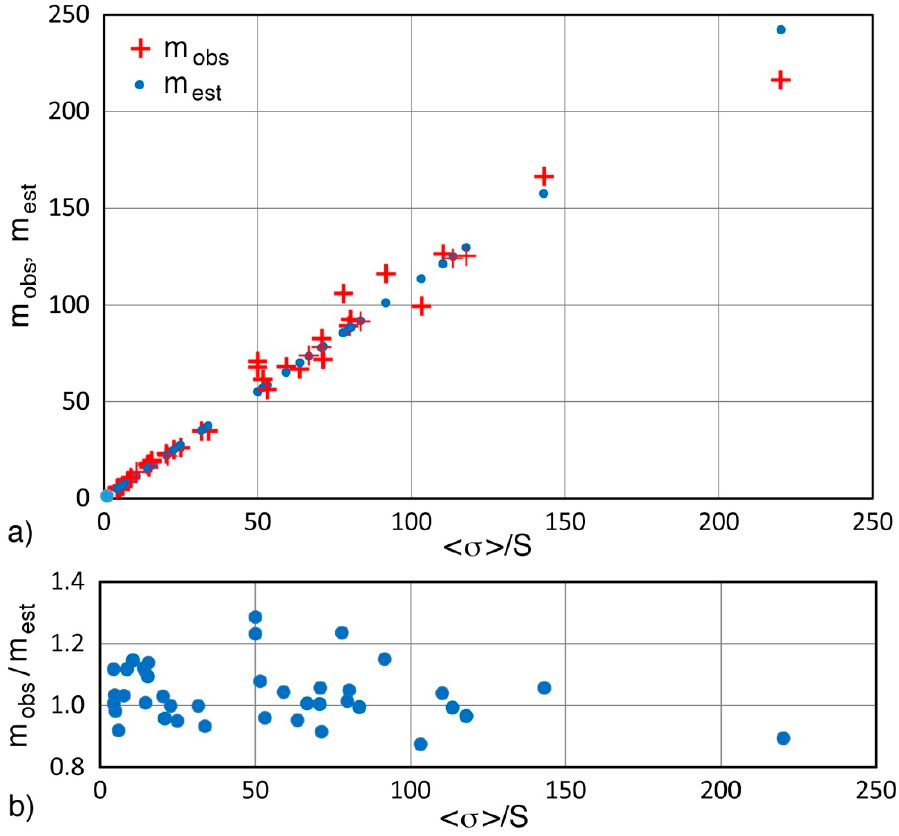
Figure 5. ( a ) Plots of m obs (red + symbol) and m est (blue dot) vs. < σ >/ S for the metal data. ( b ) Plot of m obs / m est (blue dot) vs. < σ >/ S for the same.